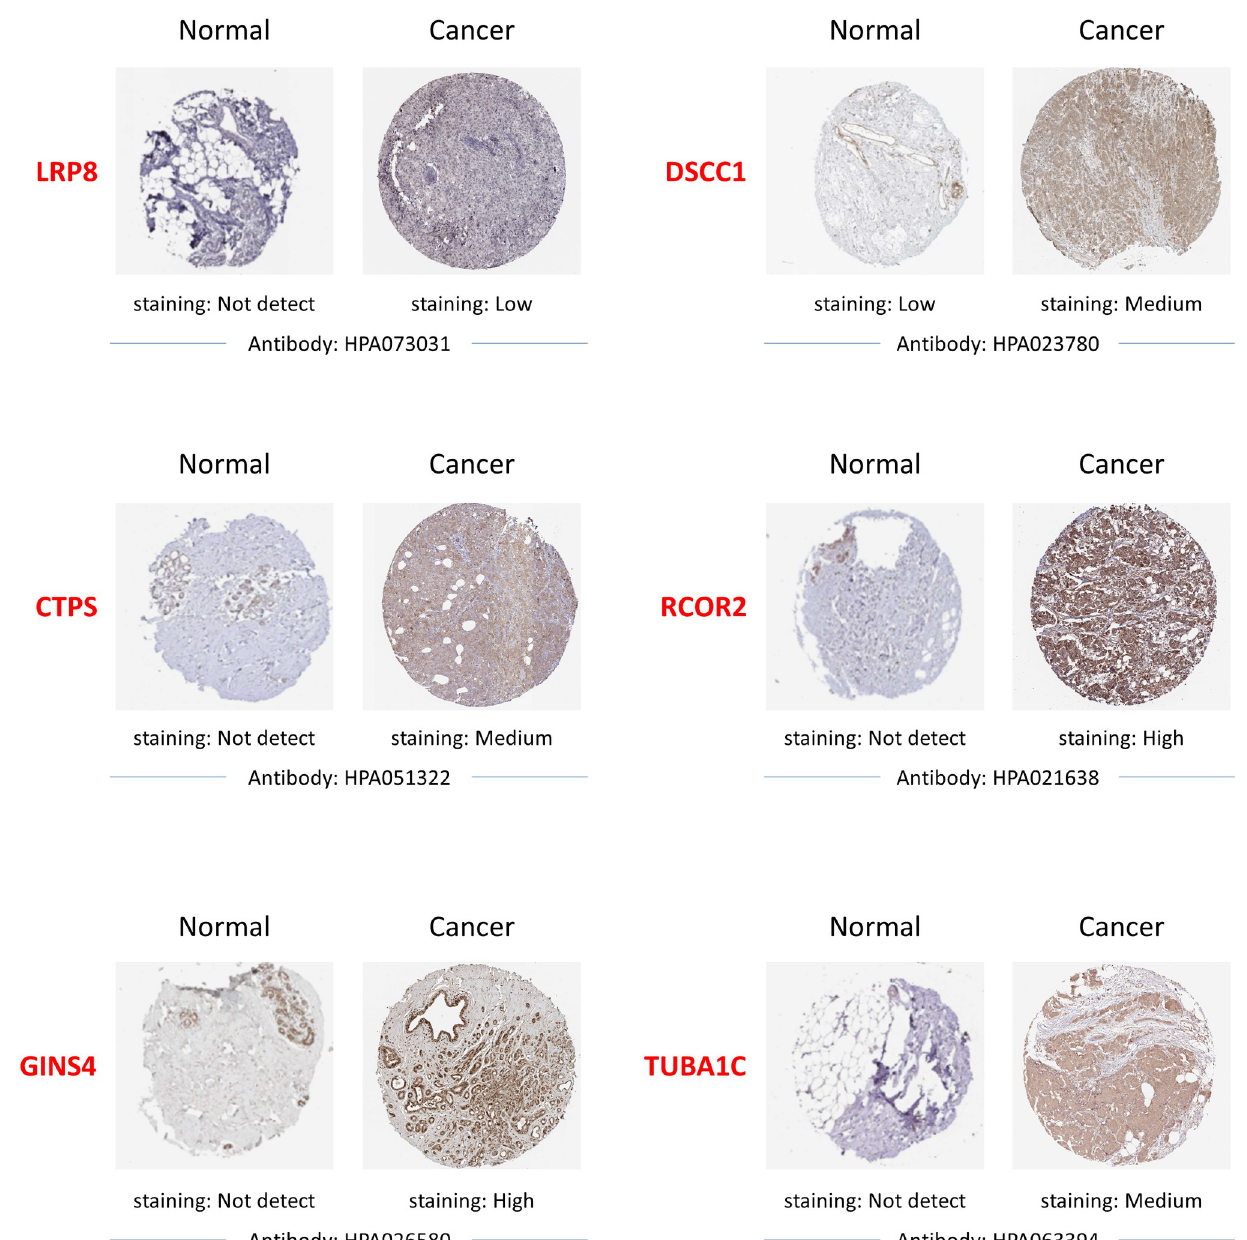
Fig 5. Immunohistochemistry results from the Human Protein Atlas. Representative immunohistochemistry images of the indicated switch genes in BC tissues and normal breast tissues obtained from the Human Protein Atlas. patients. The DNA methylation data analysis was performed on a total of 152 TCGA-BRCA patients (37 basal-like and 152 luminal A) for which DNA methylation data were available. Hierarchical clustering analysis on this data identified two main clusters and showed a differ- ent DNA methylation status of the selected genes between basal-like and luminal A patients (Fig 7b). In particular, Cluster 1 is enriched in basal-like patients (25/37, 68%, highlighted in dark blue in Fig 7b) and could be associated with a low methylation level especially for